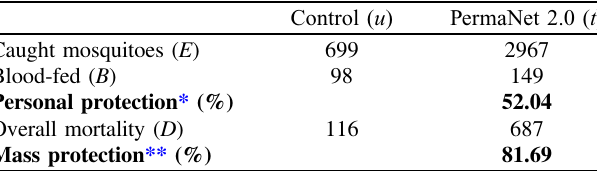
Table 5. Personal and community protection confered by